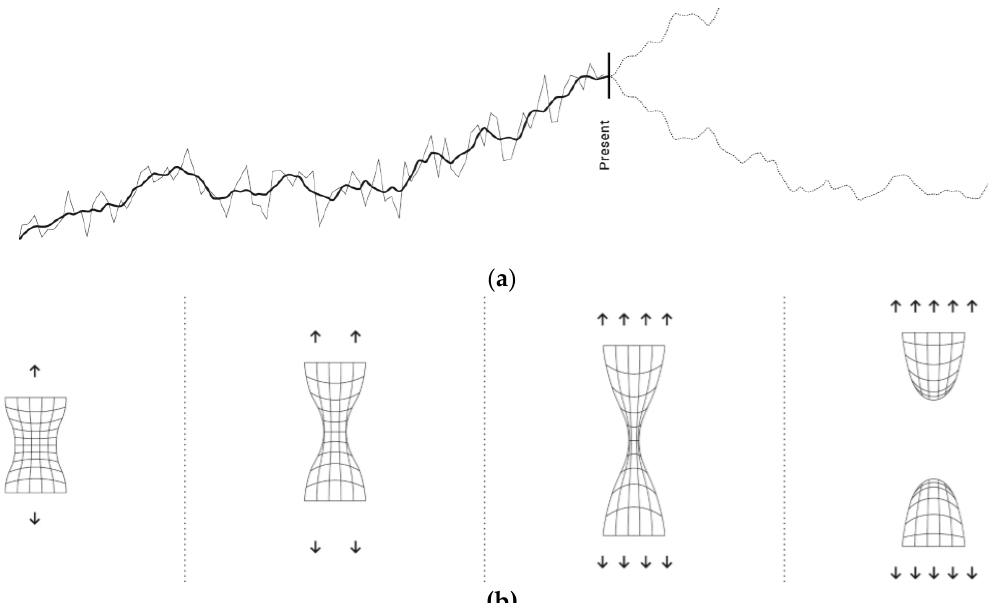
Figure 5. Different examples showing how to visualize the global warming phenomenon: ( a ) The diagram on top—usually employed to represent the rising temperature—is the histogram. It permits to assume that, in the forthcoming future (after the present mark), the temperature may possibly stabilize; ( b ) The second model is built upon a different k-interpretant privileging the pertinence of the “no-return point”. The analogic relationship is now established between the quantitative data of temperature and the quantitative energy applied to stretch a breakable surface